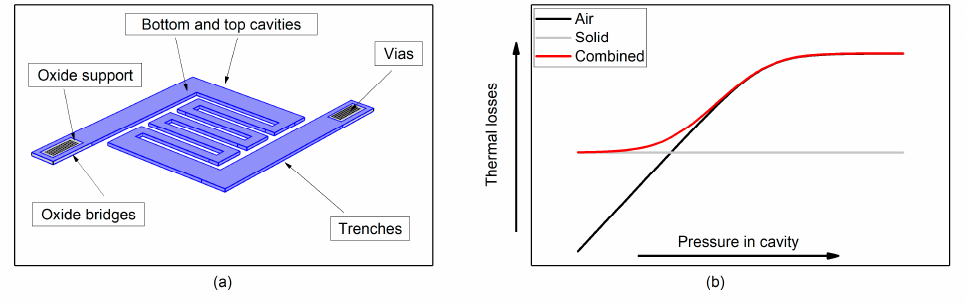
Figure 1. ( a ) Geometry and thermal loss sources, ( b ) Pressure dependency of thermal losses.